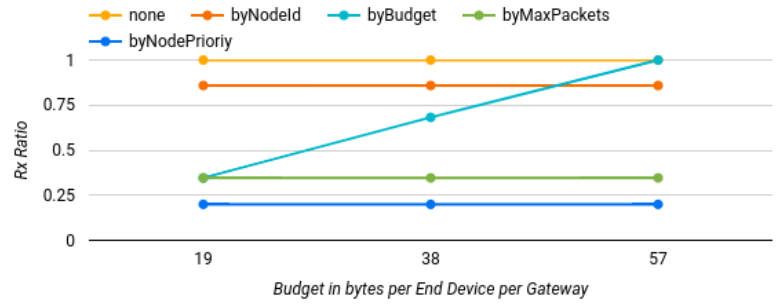
Figure 11. Results of varying the allowed budget in the different traffic-shaping